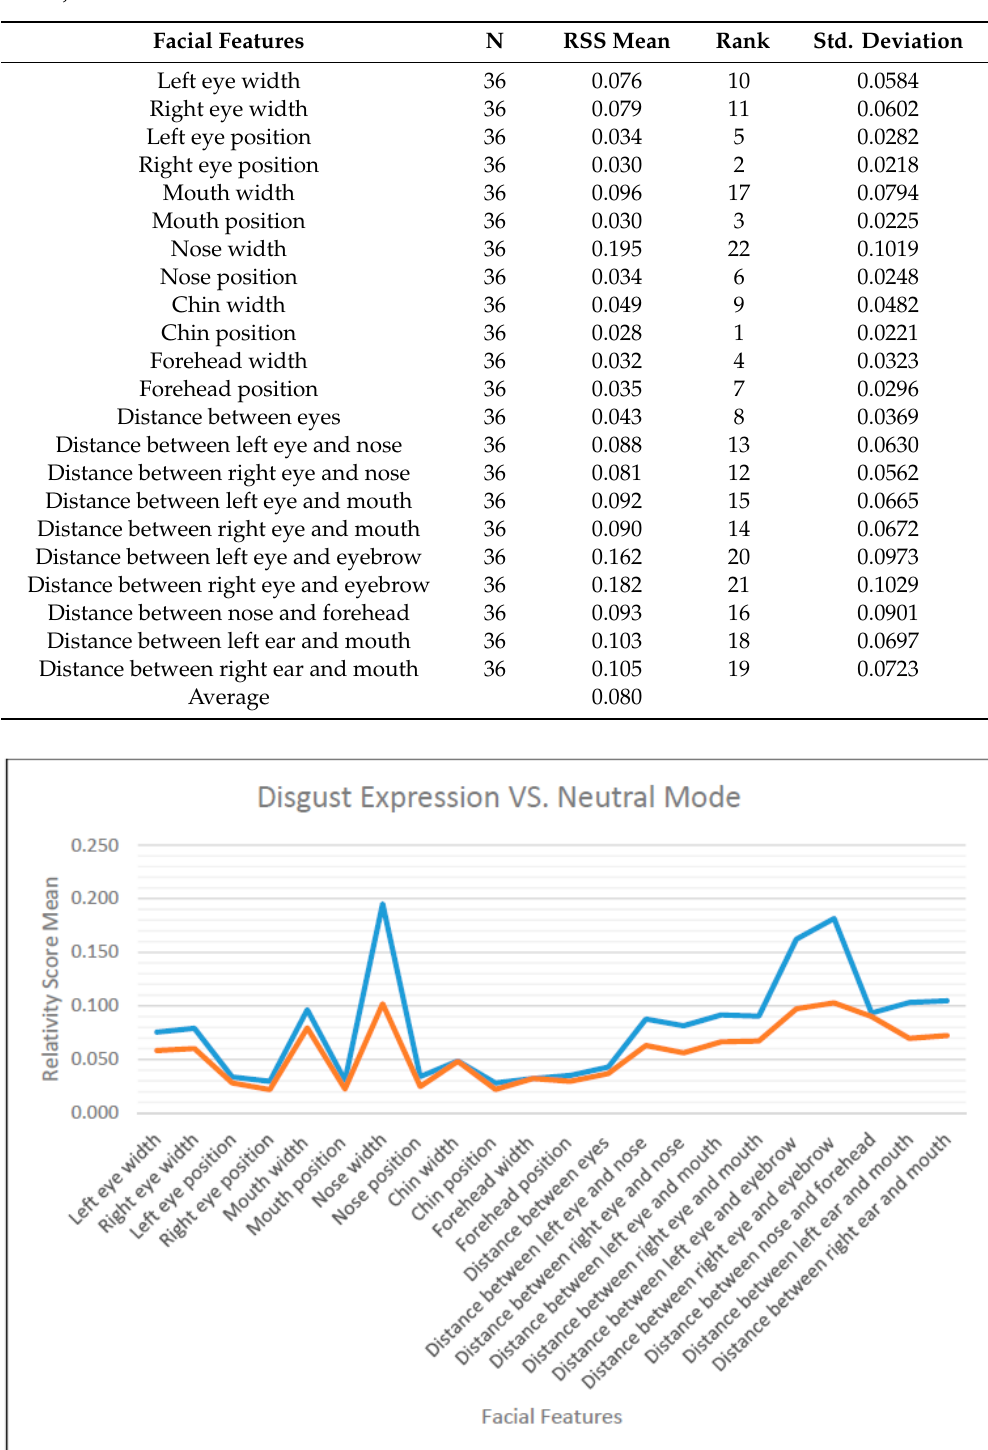
Table 7. The RSS means between disgust expression and neutral mode of 22 facial features for 36 subjects.